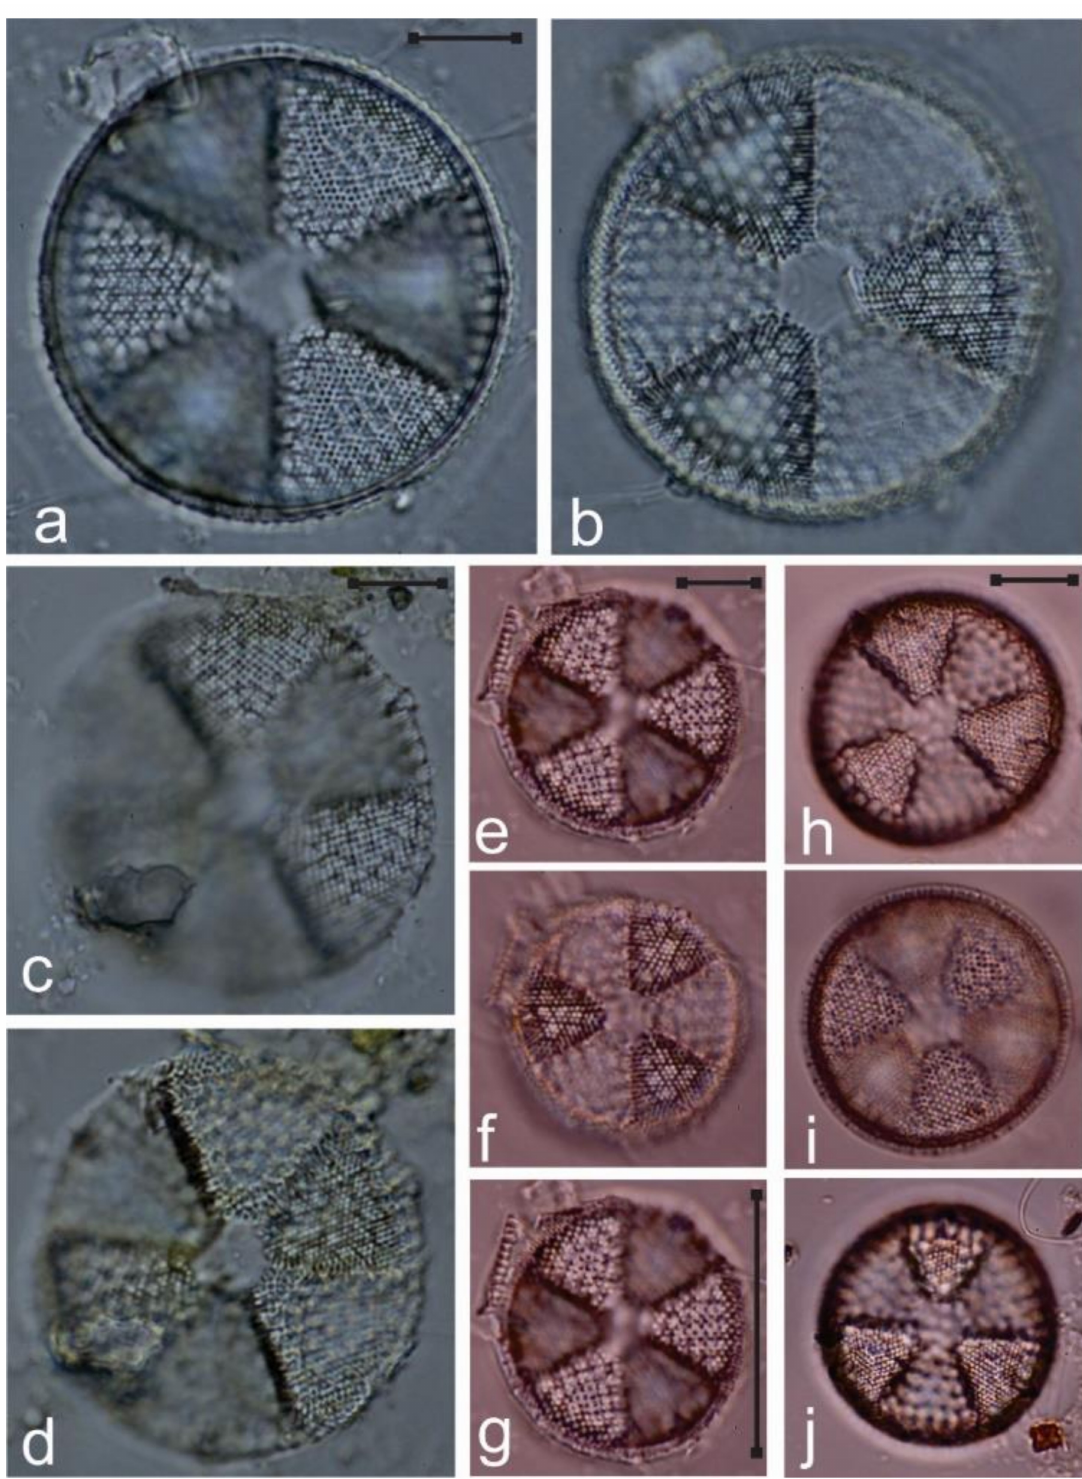
Figure 4. ( a – j ) Actinoptychus senarius in di ff erent focal planes and showing range in size. Scale bar = 10 µ